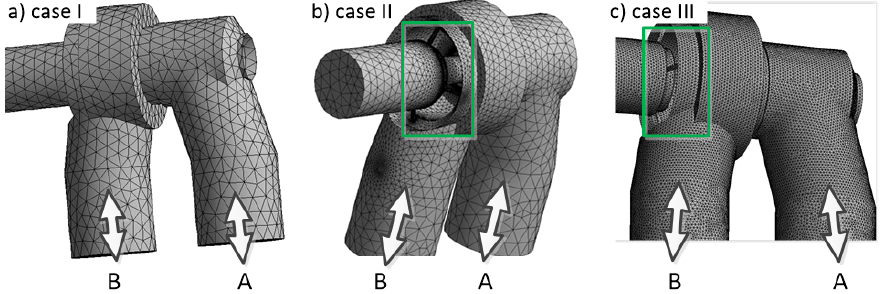
Figure 4. Mesh model with refined areas marked: ( a ) initial, ( b ) dense, refined poppet head and seat, ( c ) double dense, refined; A,B—connection ports.